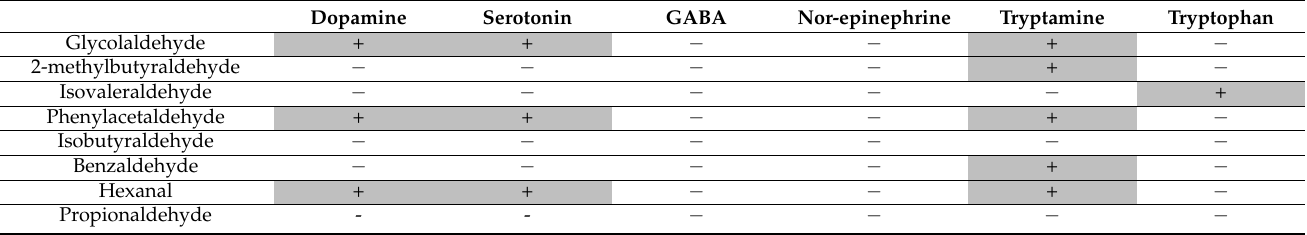
Table 7. Summary of identified condensation reaction between biogenic amines and aldehydes references identified in SAFE and HS-SDME